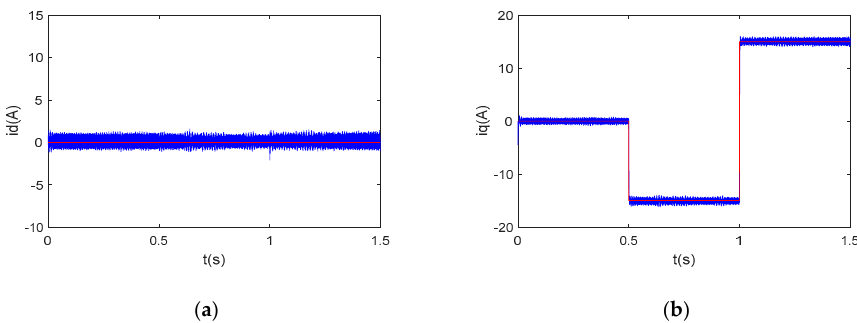
Figure 7. d-q axis current waveform of the proposed accurate discrete current controller at 6000 rpm.